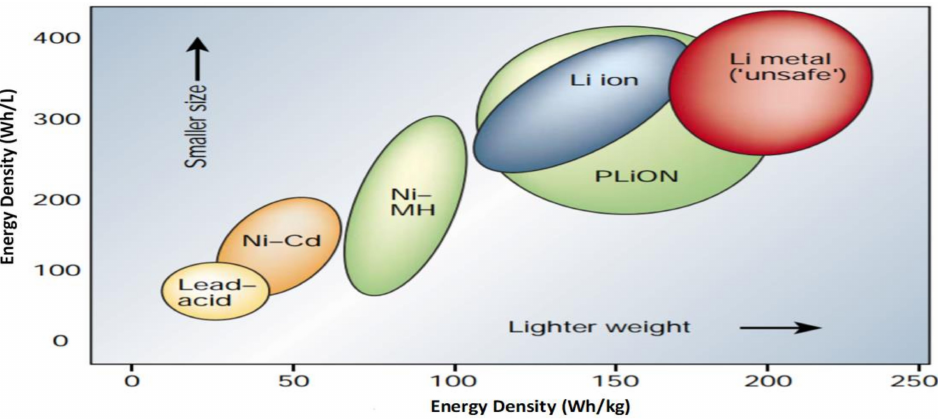
Figure 3. Comparison of size and weight of energy density [19].